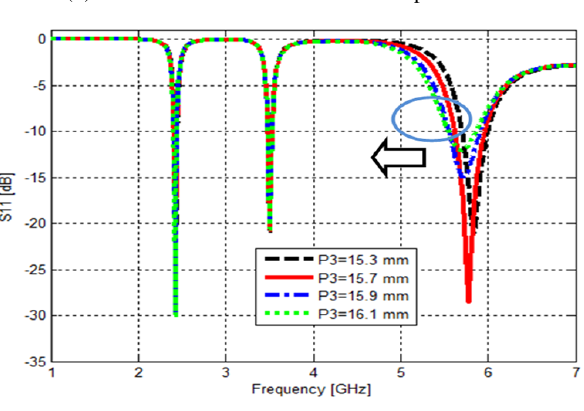
230 MHz (3.48-3.71 GHz) and 1.2GHz (5.59-6.72 GHz) which can be used for WIFI 2.45 GHz, WIMAX 3.5 GHz (3.4-3.69 GHz) and WLAN 5.8 GHz. The slight difference seen between the simulated and the measured results is ba- sically due to the manufacturing tolerances and the uncer- tainty of the thickness and dielectric relative constant of the substrate added to the quality of the SMA connector which contribute in the discrepancy recorded between the